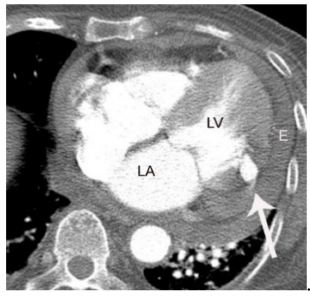
Figure 9. A case of left ventricular free-wall rupture in an 84-year-old male patient who presented with cardiogenic shock. Note the rupture site (arrow) and pericardial hematoma (E). LA and LV indicate left atrium and ventricle, respectively.